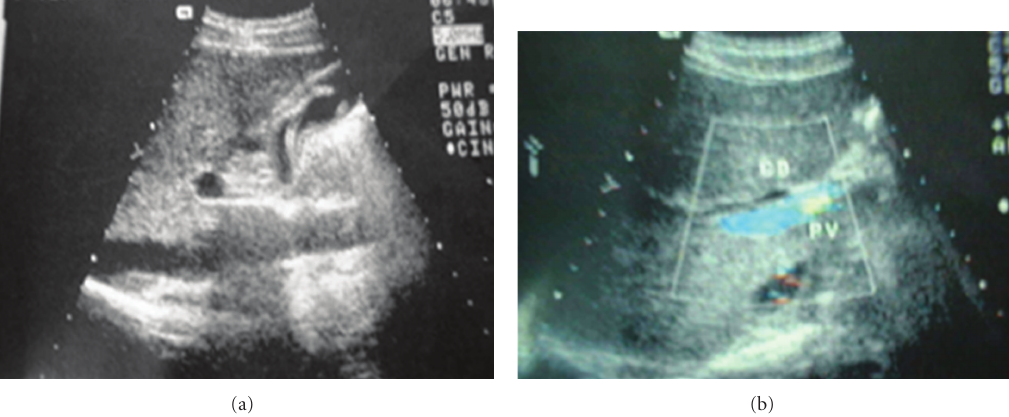
Figure 1: USG—worm in gall bladder and common bile duct.